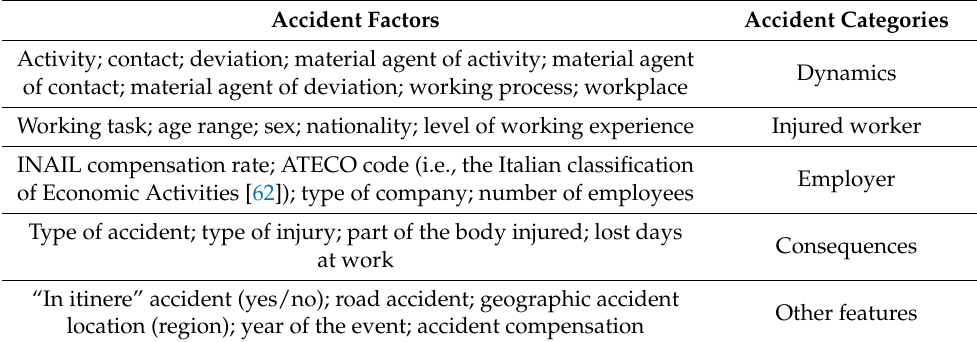
Table 3. Main features of the INAIL